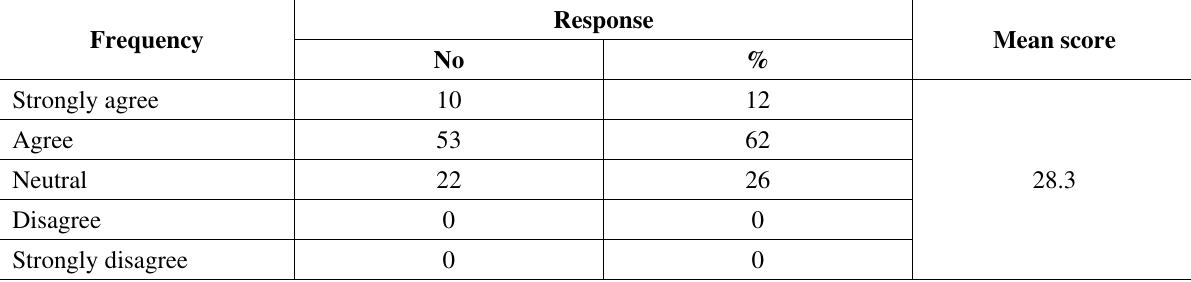
Figure 3. Theoretical Proposition 3: PPP - RISK